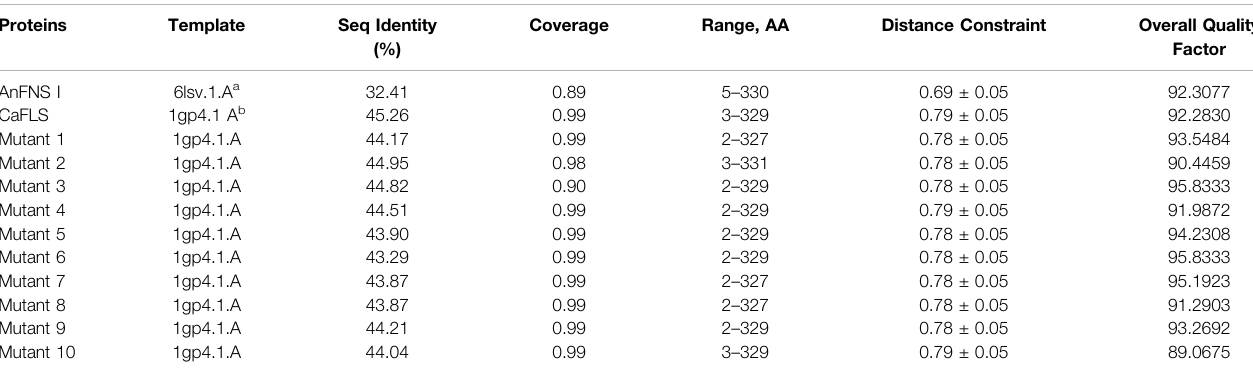
TABLE 3 | Homology modeling information of AnFNS I, CaFLS, and Mutants.